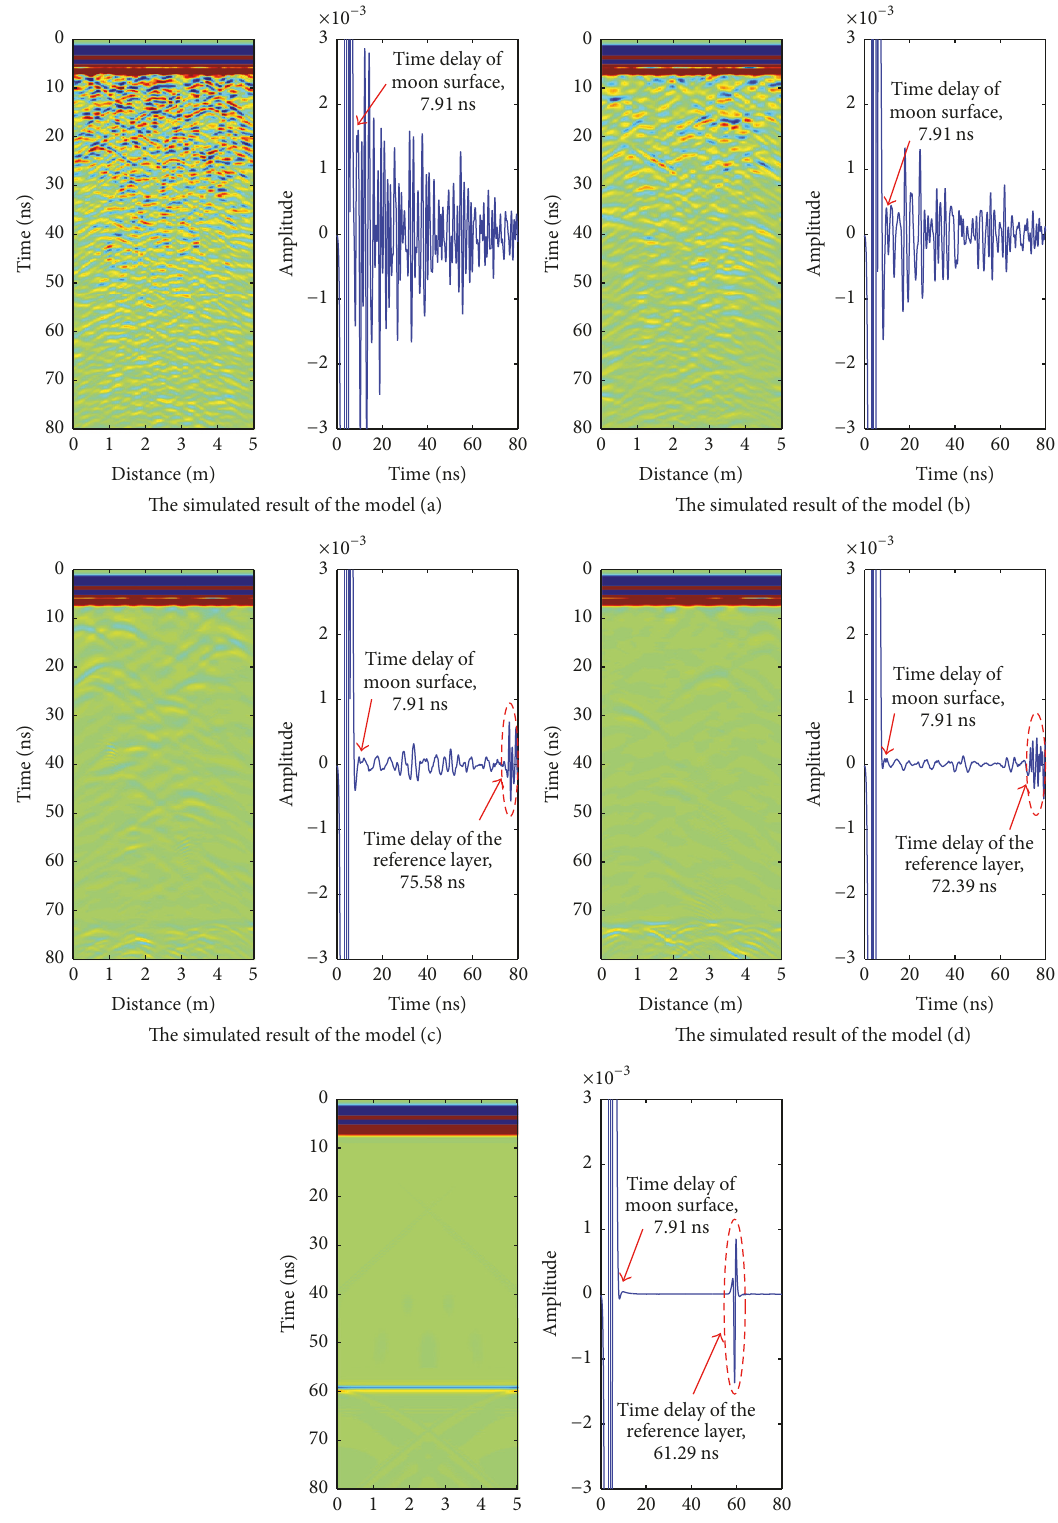
Figure 5: The A-Scan and B-Scan simulation results of the models (a), (b), (c), and (d) and the homogeneous media with the amplitude threshold at